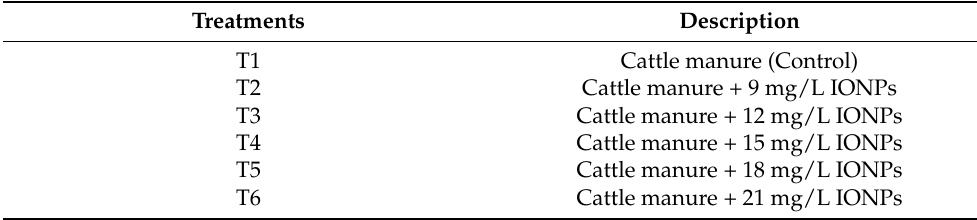
Table 1. Bio-digesters with different concentrations of IONPs for biogas production.